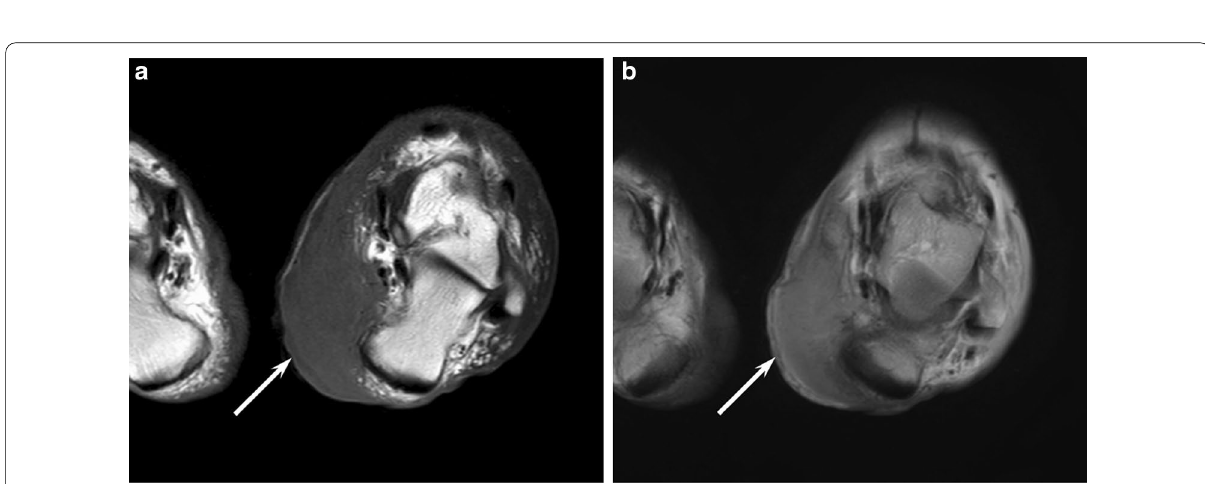
Fig. 13 A 73‑year‑old female with mycosis fungoides on the foot. a Axial T1‑weighted image showing an extensive skin thickening with a bulky subcutaneous mass (arrow). b Axial T2‑weighted image showing a subcutaneous mass with homogeneous intermediate signal intensity